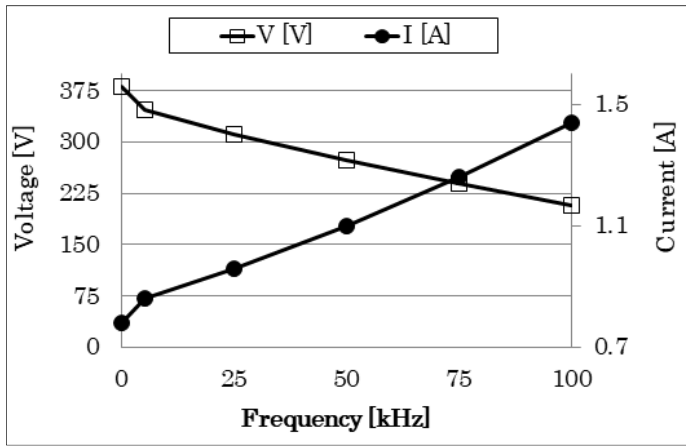
Figure 3. Voltage and current characteristics as a function of frequency in the case without the Al outer anode (the fraction of O 2 is 11.7%).